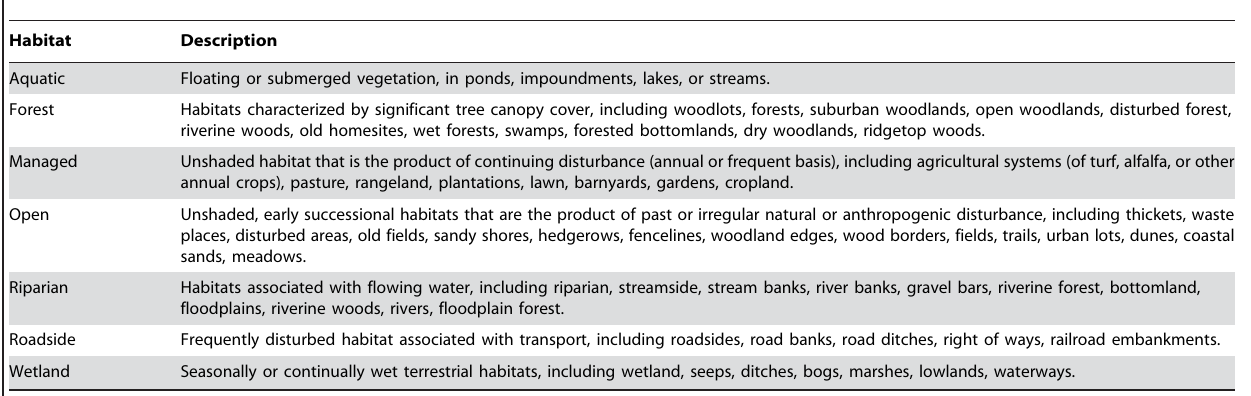
Table 1. Habitat classes describing the environmental associations of plant invaders of the Eastern U.S.